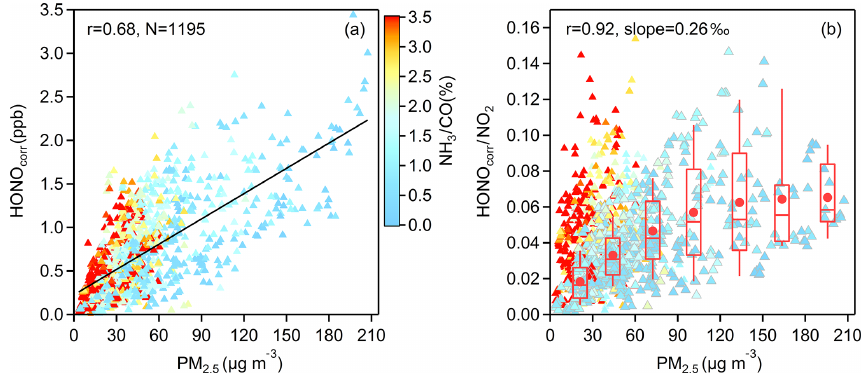
Figure 7. (a) The correlation between HONO corr and PM 2 . 5 and (b) the correlation between HONO corr / NO 2 and PM 2 . 5 ; all scatters come from the time (03:00–06:00LT) when the HONO corr / NO 2 ratio reaches the pseudo steady state each night and are colored by NH 3 / CO. In (b) , the larger triangles with gray borders depict the measured data from November to May, and the boxplot in each 30µgm − 3 interval of PM 2 . 5 is illustrated according to the same data, the red box boundaries represent interquartile range, the whiskers represent the 10%–90% percentile range, the horizontal red lines represent median values, and the red markers represent mean values. The correlation coefficient and the slope of the linearly fitted line in (b) are derived from the averaged HONO corr / NO 2 and averaged PM 2 . 5 in each